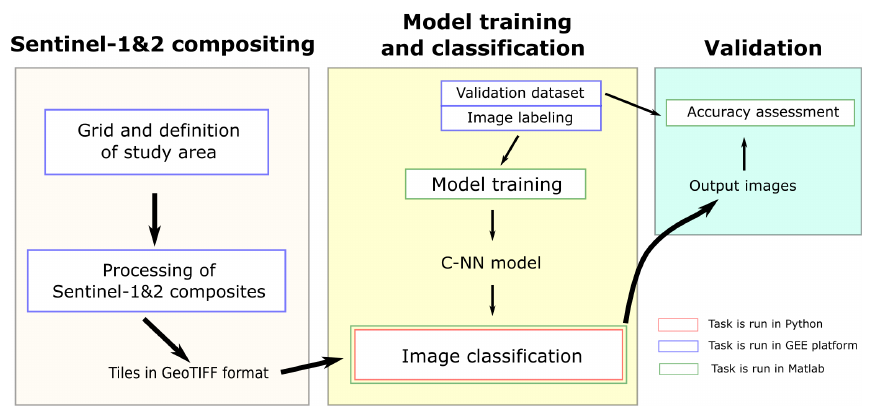
Figure A1. Diagram of the workflow for the generation of the oil palm map. The color of the square that surrounds the processing steps depicts the programming environment used. The classification of satellite images was done with Matlab 2019a, but alternatively, the images can be classified with the code distributed in